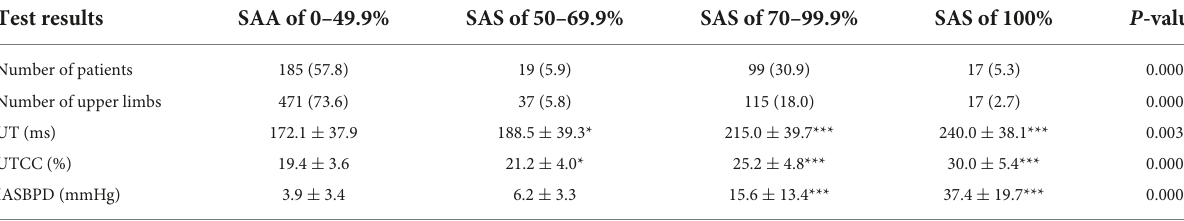
TABLE 2 The relationship between stenosis severity and relevant SAS parameters.